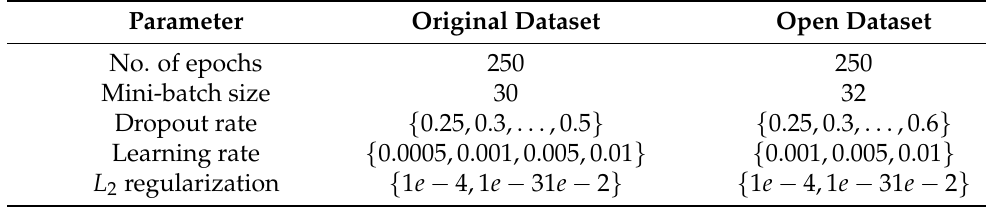
Table 2. Parameter setting of neural networks.